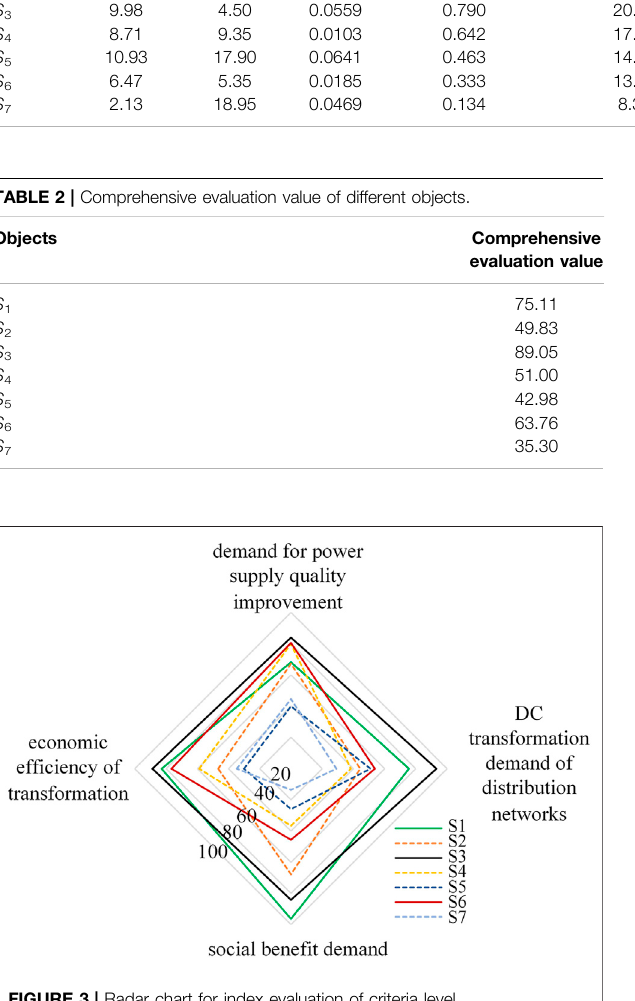
FIGURE 3 | Radar chart for index evaluation of criteria level.